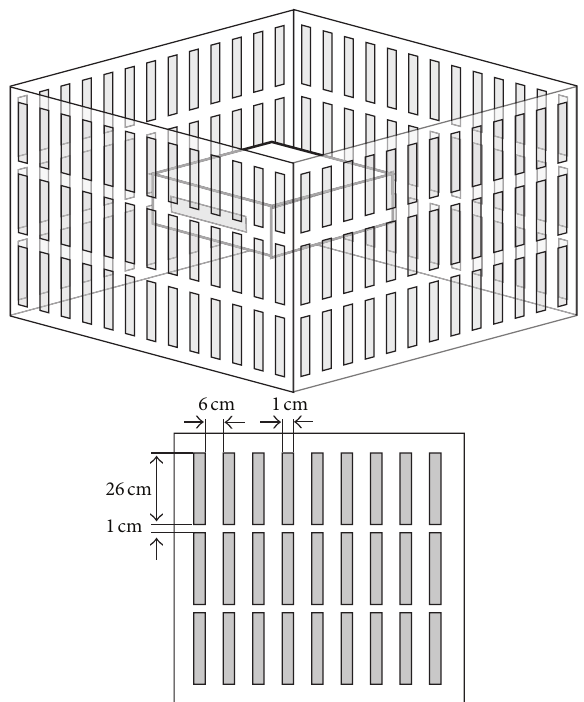
F 16: Housing the open enclosures in frequency selective walls.